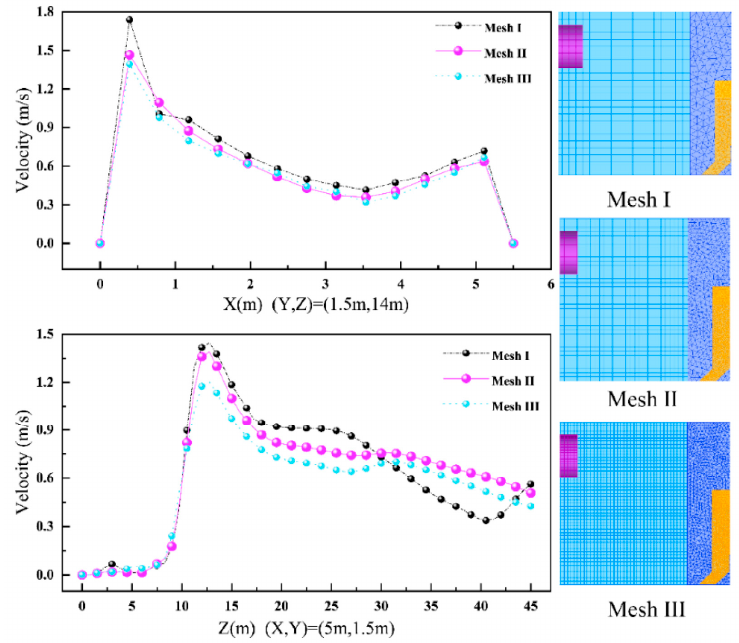
Figure 5. Mesh independence test.